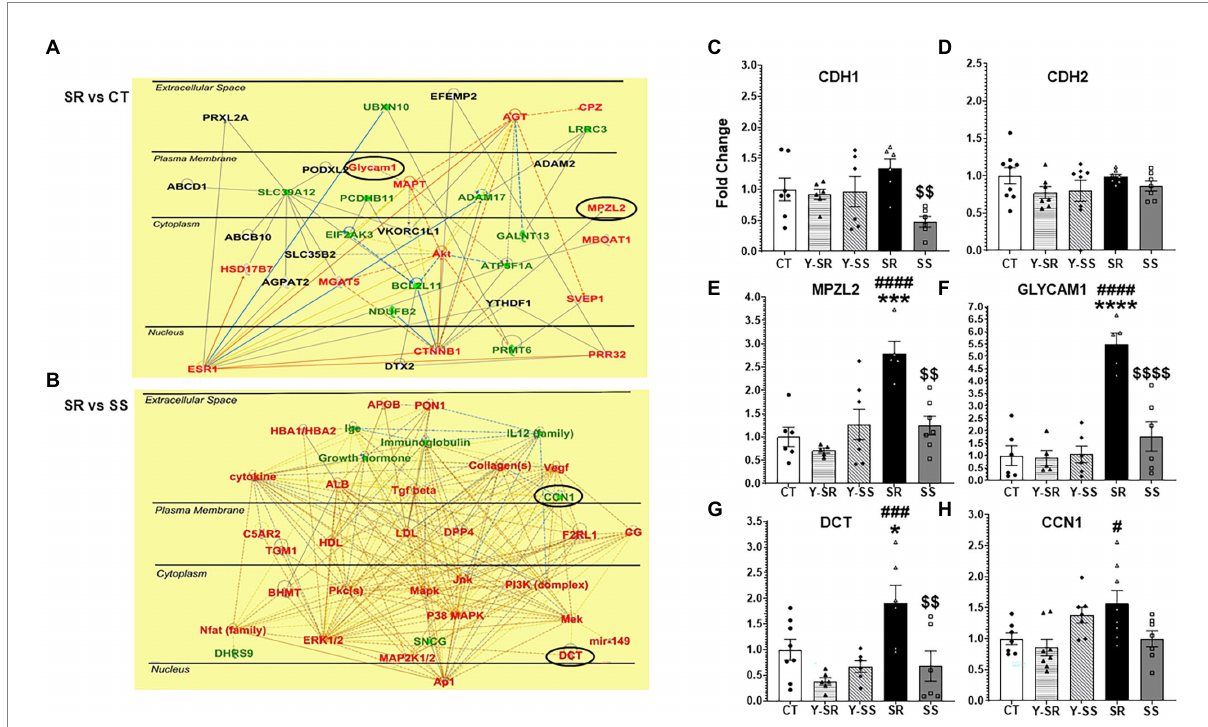
FIGURE 4 (A) Ingenuity Pathway Analysis (IPA, www.qiagen.com/ingenuity) shows the pathways that included CAMs like Glycam1 and Mpzl2 that exhibited higher mRNA expression in compulsive SR rats compared to CT rats. (B) IPA also illustrates other genes that Dct and Ccn1 interact with. The red color represents upregulated transcripts whereas the green color represents downregulated transcripts. (C–H) We used qRT-PCR to validate the changes in some CAM-related transcripts identified by the sequencing experiments. The data in the bar graphs are shown as fold-changes in comparison to control. Key to statistics: *significant to CT, # significant to paired YSR/YSS, $ significant between SR and SS; p-values : * p < 0.05, ** p < 0.01, *** p < 0.001, **** p <